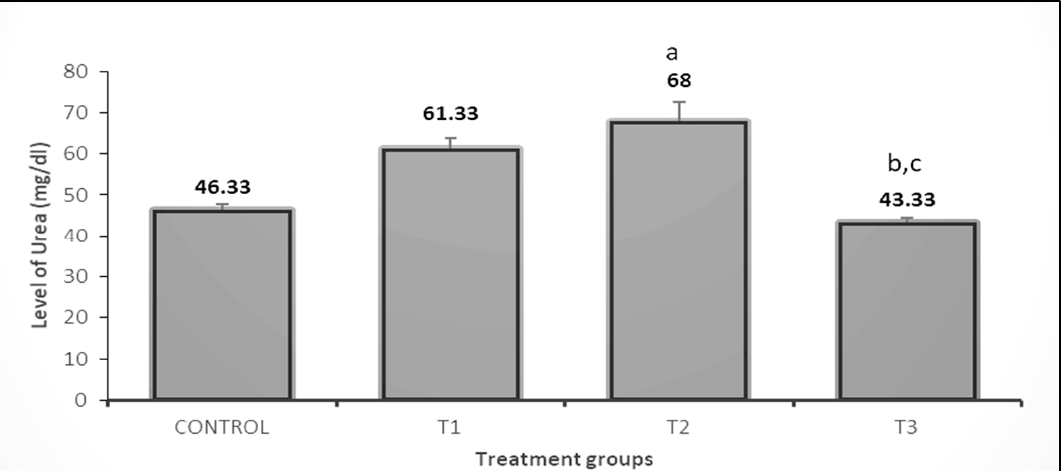
Figure 6. Effect of pomegranate peel and garlic powder separately or in combination on the level of serum urea of does. Values are presented as means ± SE (n = 5 litters). T1; T1; pomegranate peel 3%, T2; garlic 3%, and T3; pomegranate peel 1.5% + garlic 1.5%. a Significant difference as compared to control, b Significant differences as compared toT1, and c significant differences as compared to T2 ( p < 0.05).